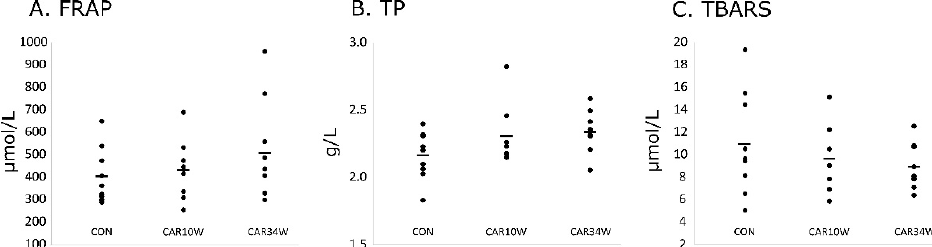
Figure 4. Comparison of the mean values of total antioxidant capacity, assessed with the ferric reducing ability of plasma (FRAP, A ) method, as well as the total phenol substances (TP, B ) and thiobarbituric acid reactive substances (TBARS, C ) concentration in the medial gastrocnemius muscle between the studied groups. CON refers to the non-supplemented group, CAR10W to the 10 weeks supplemented group, and CAR34W to the 34 weeks supplemented group. Table 2. Concentration of advanced glycation end products and the activity of hexokinase, kinase pyruvate, and citrate synthase in the left medial gastrocnemius.